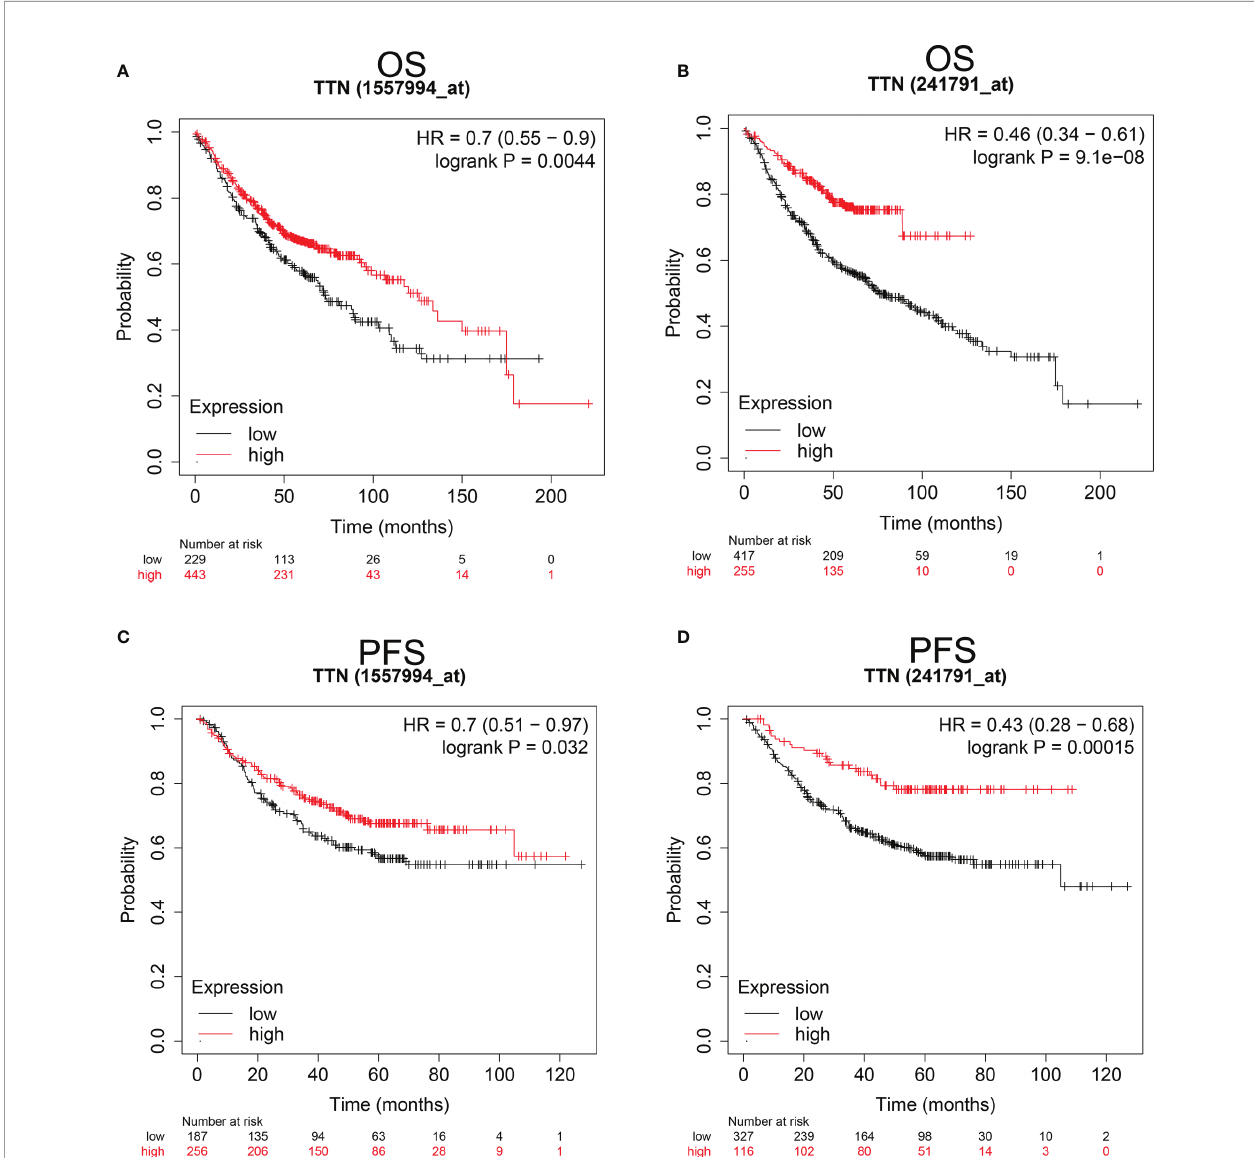
FIGURE 2 | Kaplan-Meier survival curves comparing the higher and lower expression of TTN in LUAD Kaplan-Meier plotter database. OS and PFS of LUAD patients in the Kaplan-Meier plotter database (A – D) . Red curves represented patients with higher expression of TTN . OS, overall survival; RFS, relapse-free survival. PFS, progress-free